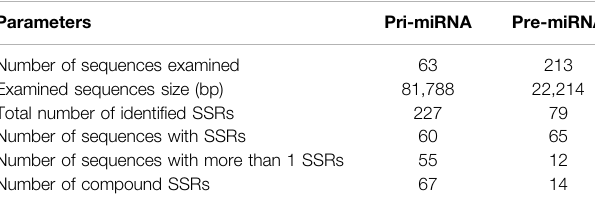
TABLE 1 | Characterization of SSRs in pri- and pre-miRNA sequences of pomegranate genome.